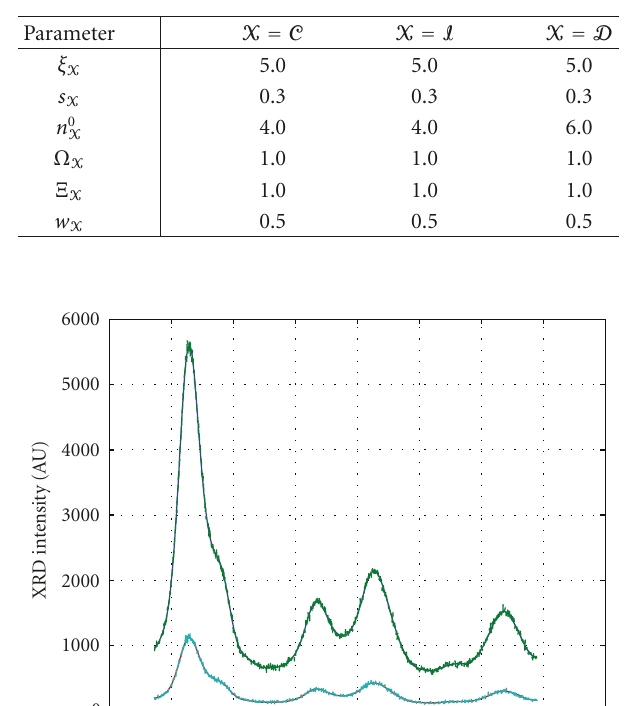
Table 1: Values of parameters used in (6) to compute synthetic XRD intensity profiles. The wavelength and the f.c.c. bulk lattice constant were set to λ = 0 . 15418 nm and a f.c.c. = 0 . 40786 nm, re- spectively.